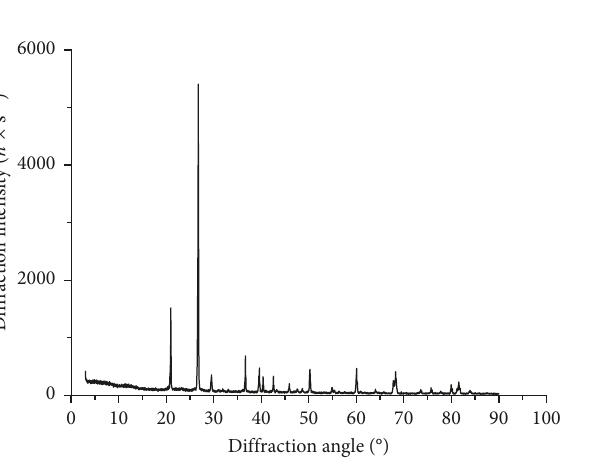
Figure 2: XRD spectrum of red mudstone.